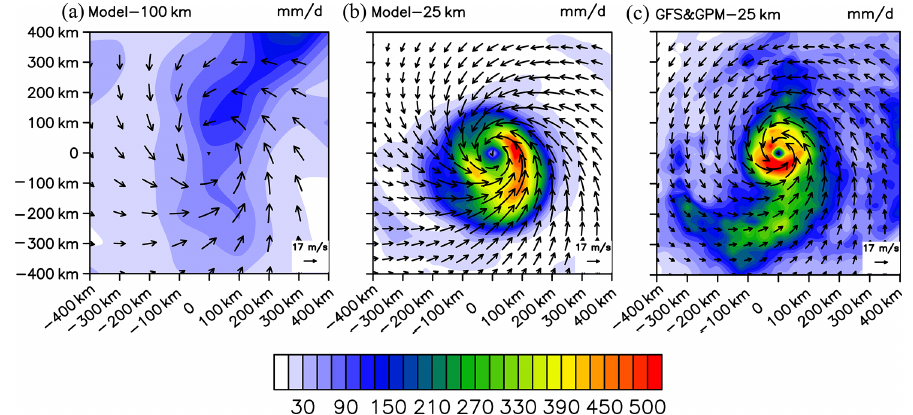
Figure 9. Surface 10m winds (units: ms − 1 ) and daily precipitation rate (mmd − 1 ) for the horizontal composite of the 30 most intense tropical cyclones in (a) FGOALS-f3-L and (b) FGOALS-f3-H. (c) Results of the surface 10m wind in GFS and the daily precipitation rate in GPM. Radius is 4 ◦